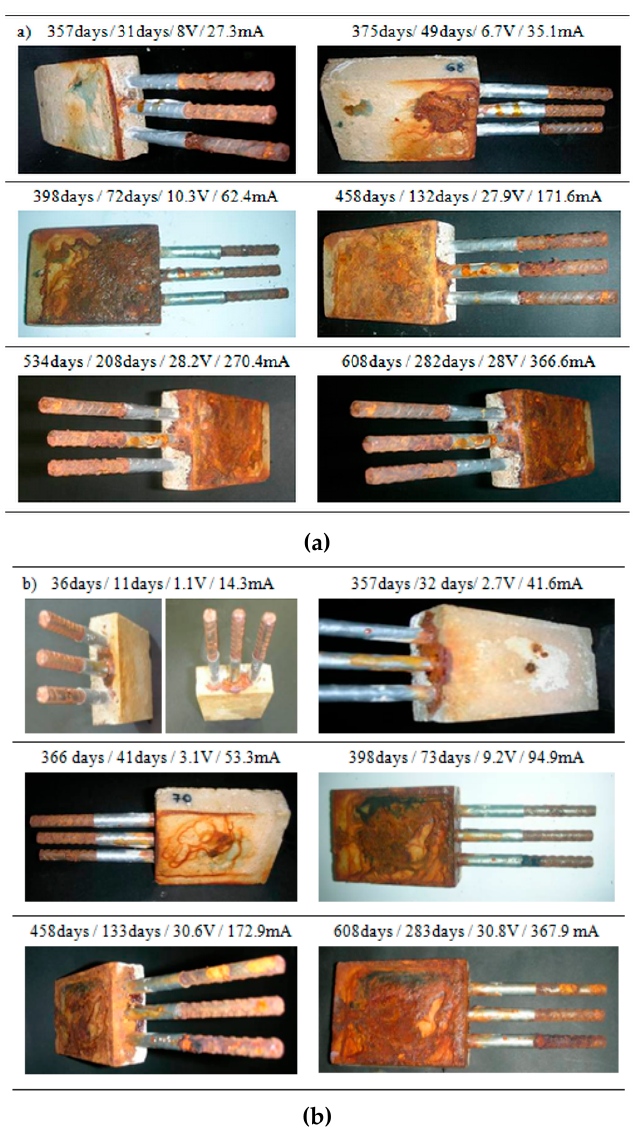
Figure 6. Symptoms in the MCC test specimen with 1.2% chloride ions ( a ) and 2% chloride ions ( b ).